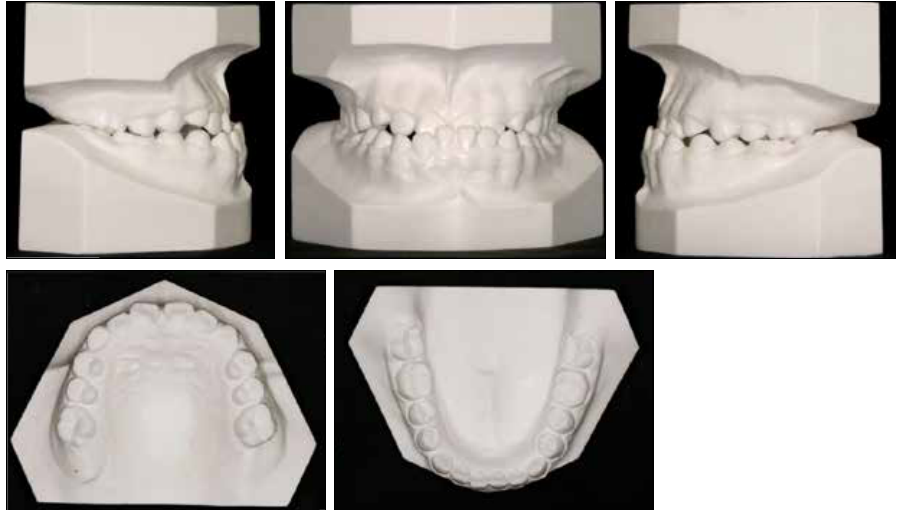
Figure 2. Pretreatment dental casts. Table I. Cephalometric analysis at various stages of the two-phase